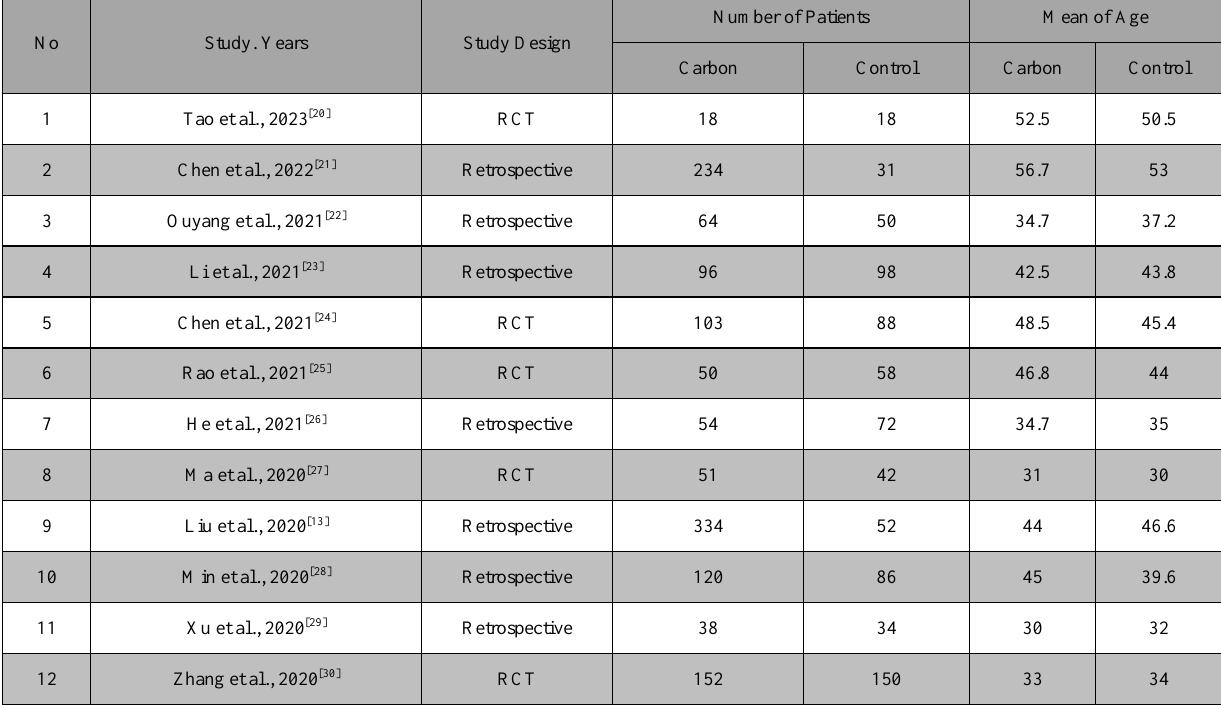
Table 2. Demographic information was extracted from the full text of the selected